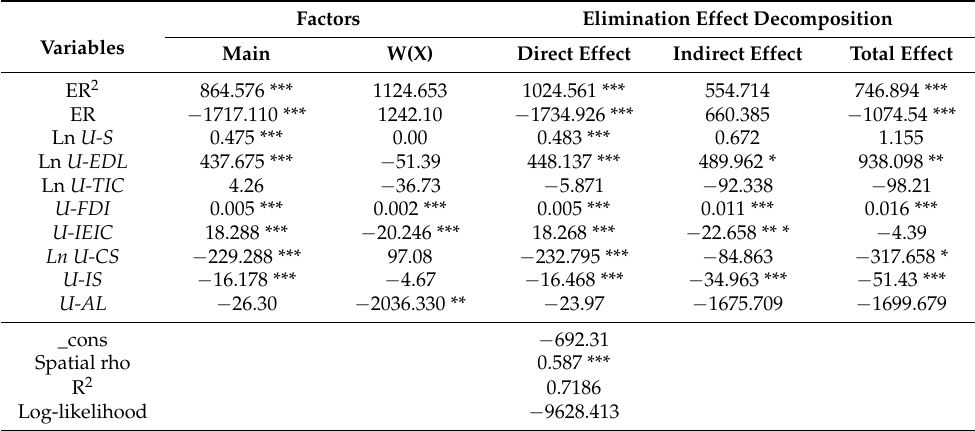
Table 10. Results of the spatial Durbin model (SDM).